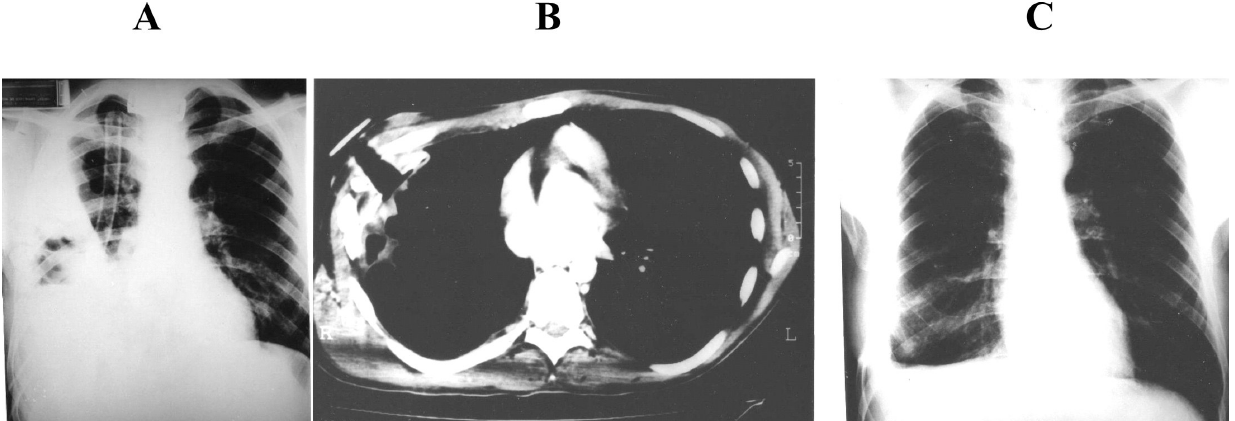
Figure 3 - A: Massive parapneumonic empyema in the right hemithorax. Although adequately drained, the lung did not re-expand and there was some remaining air-fluid. B: CT-scan four months after POP insertion. The lung has been completely re-expanded. POP was removed at this occasion. C: Chest X-Ray one month after POP